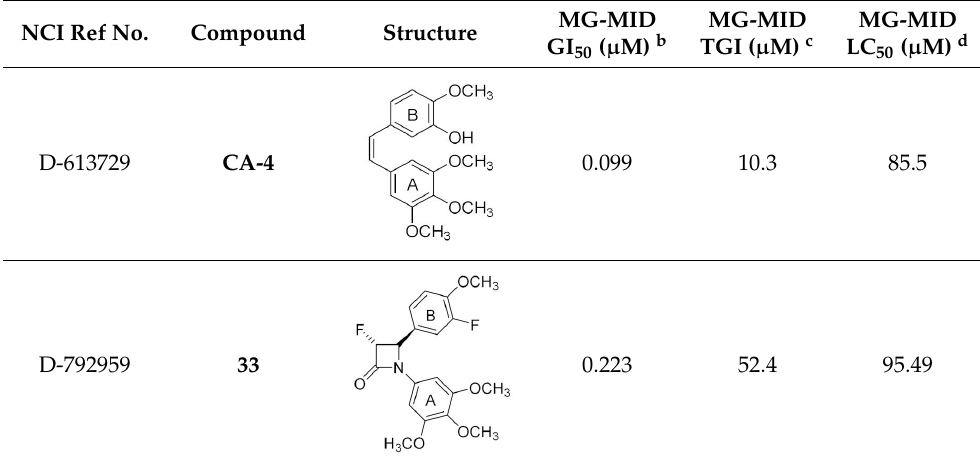
Table 6. NCI 60 cell line in vitro primary screening results for compound 33 a . NCI Ref